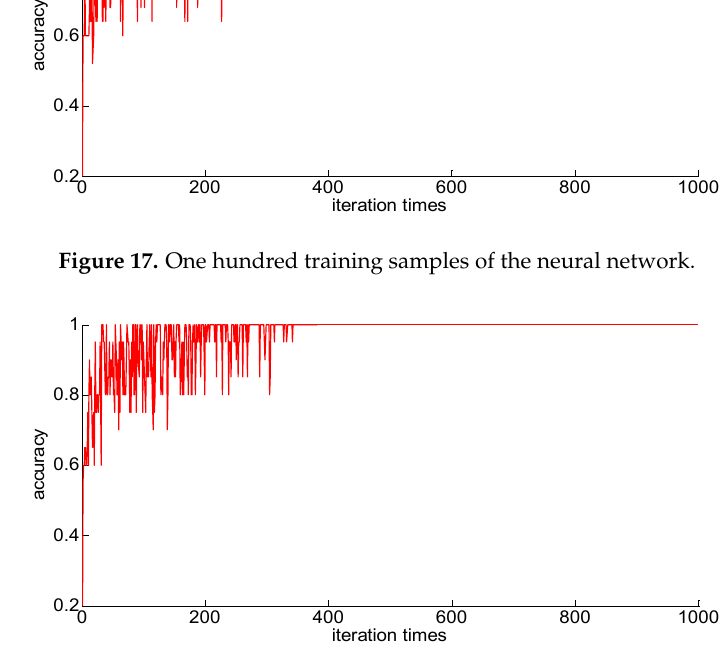
Figure 19. One hundred fifty training samples of the neural network. After completing the training, four indexes for evaluating the training effect are counted, and the training effect of the model after adding the new feature is compared with the training effect of the previous model. The results are shown in Table 13. Similarly, the number of iterations for different sample size models to converge is also different, and the corresponding iterations are set